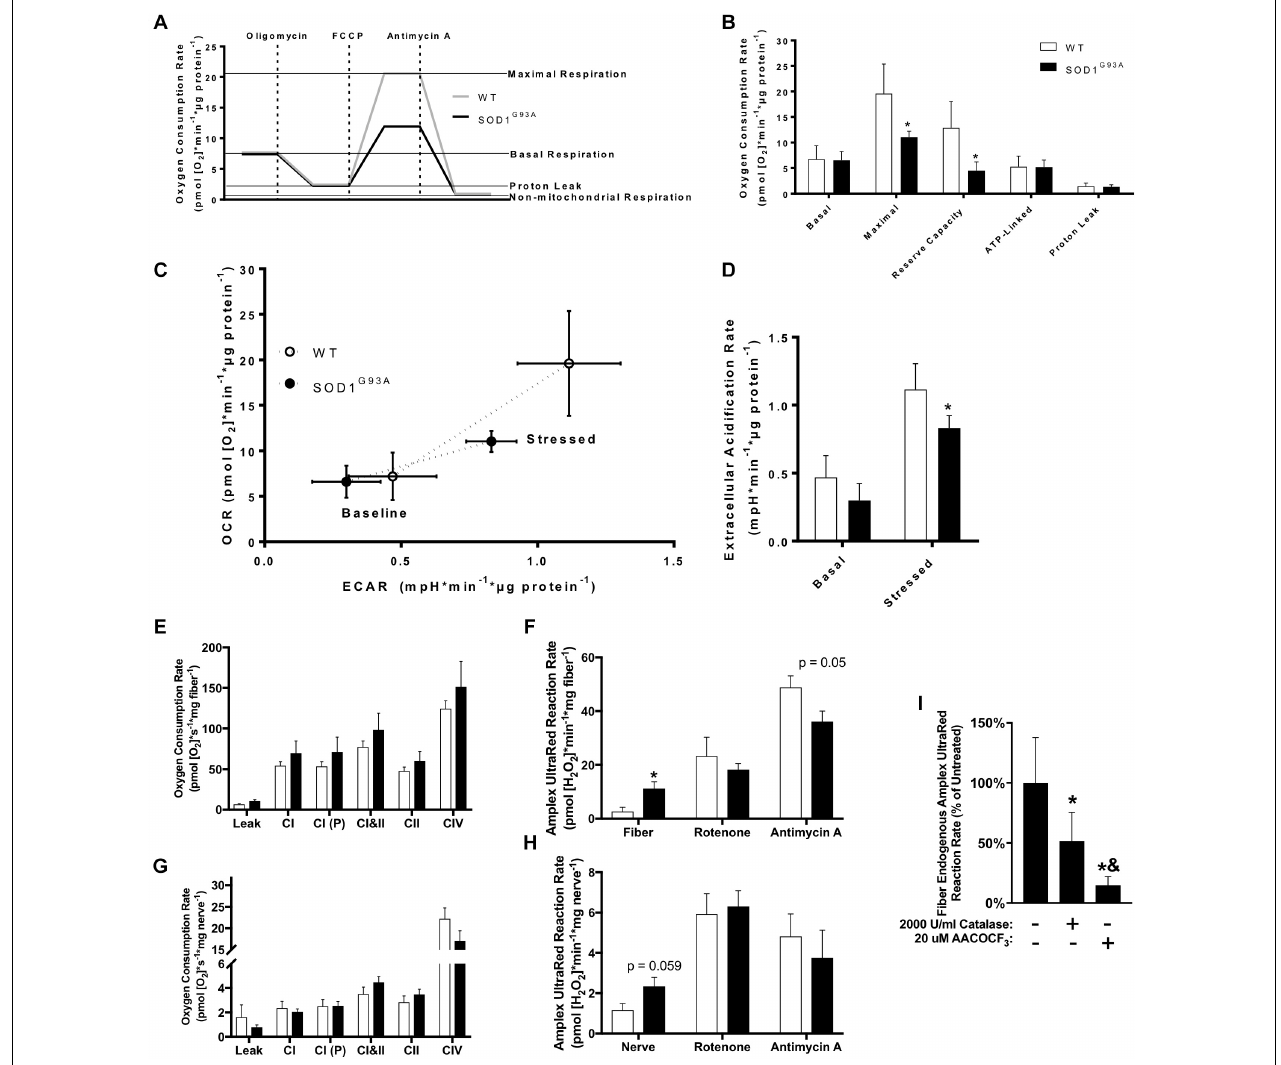
FIGURE 7 | Mitochondrial function in cultured fibroblasts, sciatic nerve tissue, and permeabilized muscle fibers of SOD1 G93A mice. (A) Schematic showing the output from Seahorse XF24 Flux Analyzer and calculation of measurements. (B) Oxygen consumption rate (OCR), (C) Extracellular acidification rate (ECAR), and (D) Comparison of OCR and ECAR of dermal fibroblasts isolated from wild-type (WT) and SOD1 G93A mice ( n = 5) measured by Seahorse XF24 Flux Analyzer. Stressed ECAR was measured in the presence of oligomycin and FCCP. Simultaneous OCR and hydrogen peroxide and lipid hydroperoxide production rates (Amplex UltraRed) were assessed in permeabilized sciatic nerves ( n = 8–11) and red gastrocnemius fiber biopsies ( n = 7–9) from end-stage female mice using the OROBOROS Oxygraph-2k with fluorometer. (E) Gastrocnemius fiber OCR. (F) Gastrocnemius fiber hydrogen peroxide and lipid hydroperoxide production rates. (G) Sciatic nerve OCR. (H) Sciatic nerve hydrogen peroxide and lipid hydroperoxide production rates. ∗ p < 0.05 wild-type vs. SOD1 G93A determined by unpaired student’s t -test. (I) Basal hydrogen peroxide and lipid hydroperoxide production rates for SOD1 G93A gastrocnemius fibers in the OROBOROS O2K fluorometer vehicle treated, or pre-treated with 2000 U/ml Catalase or 20 µ M AACOCF 3 ( n = 7). ∗ p < 0.05 treated (either catalase or AACOCF 3 ) vs. untreated control, & p < 0.05 catalase vs. AACOCF 3 treated. Substrate-inhibitor protocol and definitions of states are described in Materials and Methods. Bars represent means ± standard deviation. Wild-type (white) and SOD1 G93A (black). CI, mitochondrial Complex I (with glutamate, malate, and ADP); CI(P), mitochondrial Complex I (with